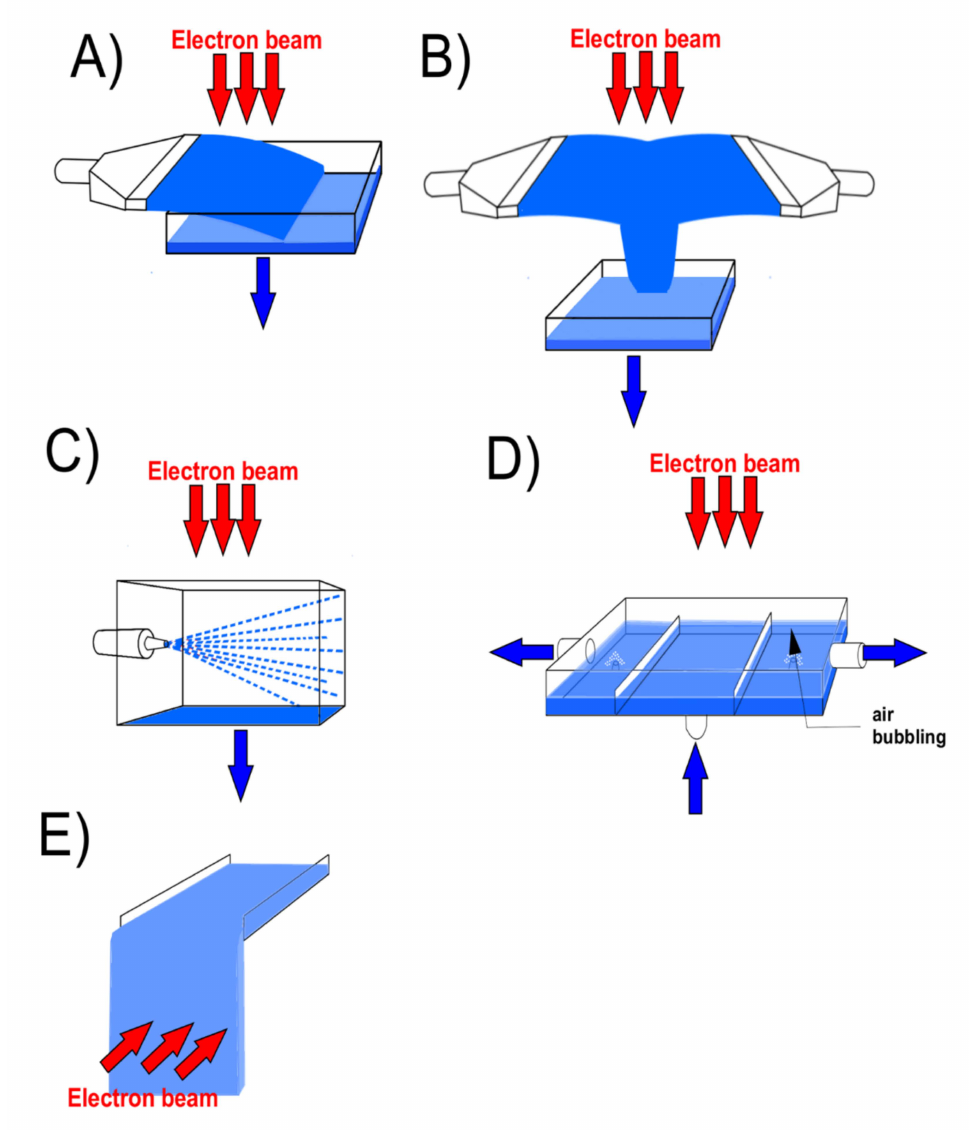
Figure 1. Different geometry of stream configuration for wastewater irradiation: ( A ) jet injection, ( B) two opposite jets injection, ( C ) sprayer, ( D ) up-flow system with air bubbling, ( E ) natural